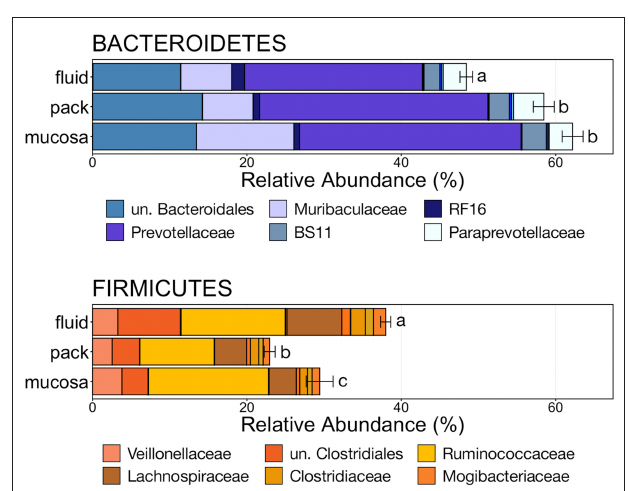
FIGURE 5 | Bar plot showing the relative abundances of the phyla Bacteroidetes and Firmicutes. Error bars display the standard error of the mean for each phylum and colors represent the relative abundance of families of the two phyla within rumen fluid, pack, and mucosa-associated communities. The top six most abundant families within each phylum are displayed in the legend. Significant differences in the relative abundance of the two phyla are illustrated by different letters (Pairwise Wilcoxon rank-sum with Benjamini-Hochberg correction, p < 0.05, n = 12). un,